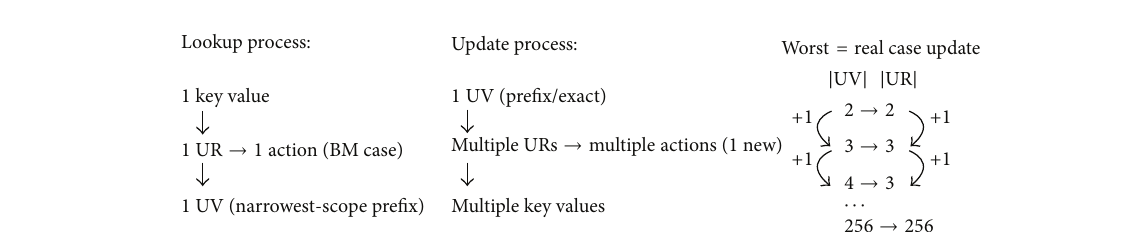
Figure 4: Multimatch (MM) processing.